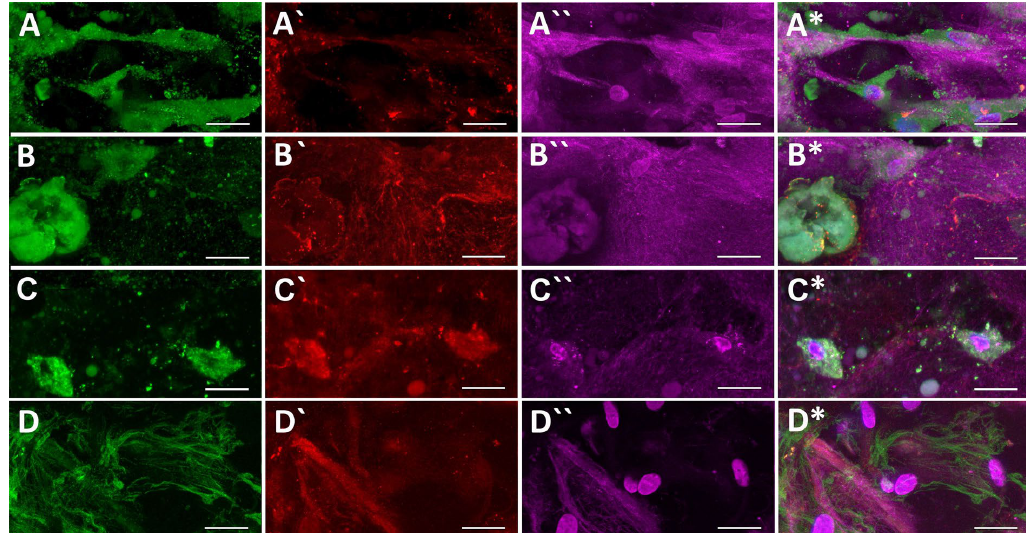
Figure 9. Immunofluorescence staining of fibronectin (green, A – D , A* – D* ), type I collagen (red, A` – D` , A* – D* ), second harmonic generation signal of fibrous collagen (purple, A`` – D`` , A* – D* ) in ASCs in collagen gel. The cells were cultured in DMEM with 2% of FS ( A , A` , A`` , A* ), in medium with added PVA nanomats ( B , B` , B`` , B* ), with added PVA_PL nanomats ( C , C` , C`` , C* ) or in medium with TGF- β 1 + BPM-4 ( D , D` , D`` , D* ) for 7 days. Zeiss, LSM 780 microscope system, obj. × 63×, image size 135 µm × 67 µm, scale bar = 25 µm.